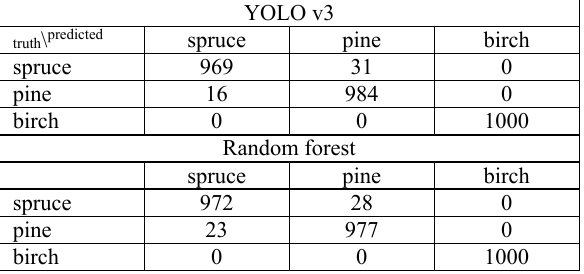
Table 5. The results from Table 6, converted into three main tree classes.